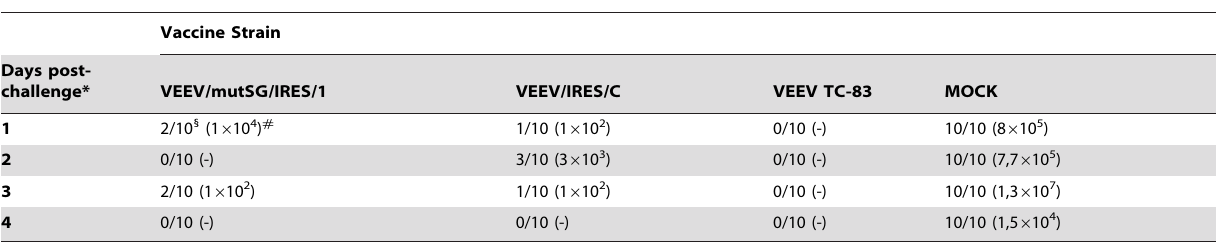
Table 4. Viremia in vaccinated adult mice after challenge.